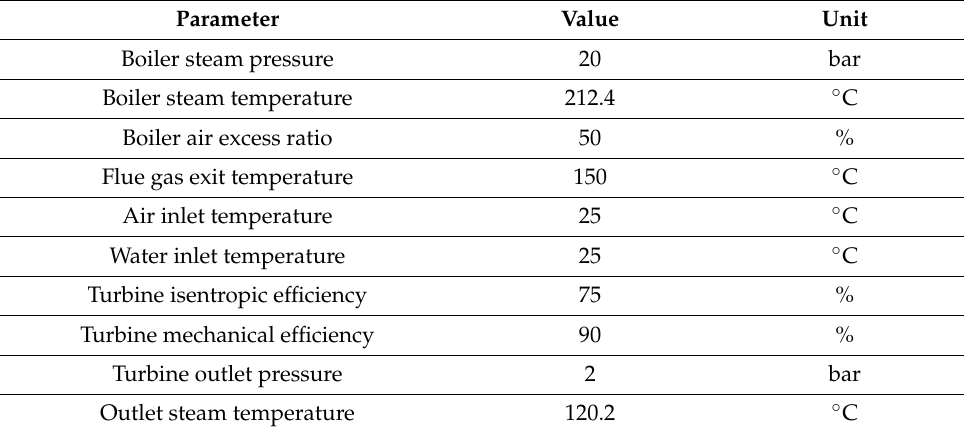
Table 3. Operation parameters for simulation of the biomass CHP systems.